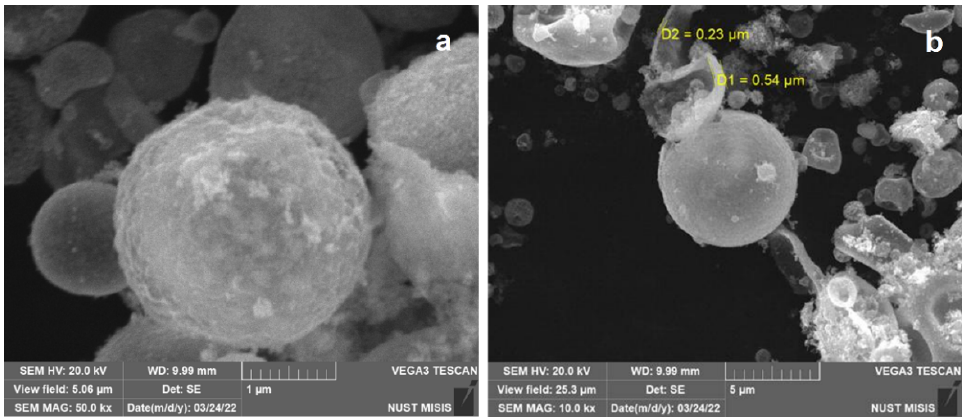
Figure 6. Structure analysis of CuO microspheres (SEM): general view of the microsphere ( a ), view of microsphere cleavage with measurement parameters ( b ).